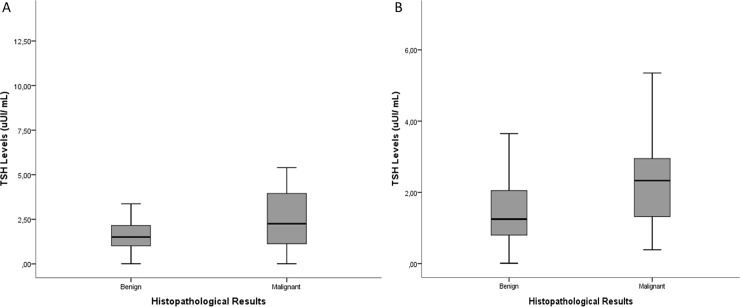
TSH level in malignant and benign thyroid nodules.CLIA, Chemiluminescent immunoassay; ECLIA, electrochemiluminscent immunoassay. Box plot illustrating the median TSH level and the TSH level quartiles and ranges in malignant and benign thyroid nodules for CLIA(A) and ECLIA (B). Patients with thyroid cancer exhibited higher median TSH levels than patients with benign nodules for both methodology. P = 0.04 (A) and P = 0.03 (B).